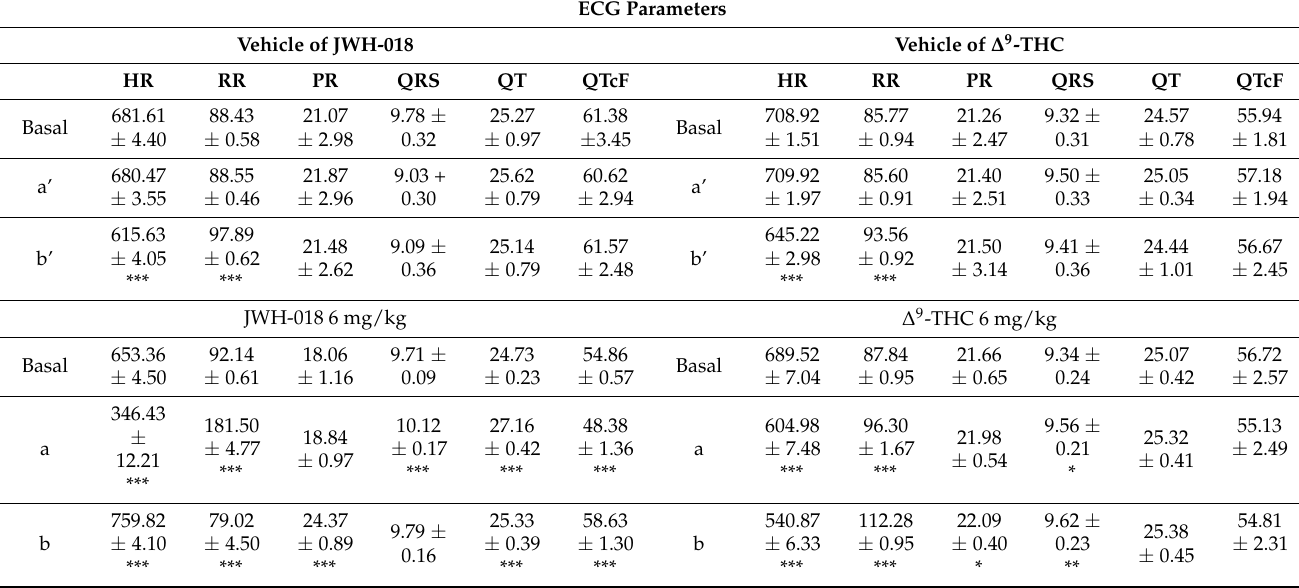
Table 1. Effect of systemic administration of vehicle (a’, b’), JWH-018 6 mg/kg (a and b) and ∆ 9 -THC 6 mg/kg on cardiac electrical parameters (ECG analysis). Data are relative to HR dose–response curve (Figure 2A,B). Data are expressed as mean overall effects of 15 evaluations for baseline and after vehicle or JWH-018 treatment of 4 mice. Data were analyzed with iox2 software, and they are expressed as MEAN ± SEM of evaluations recorded in 1-min time window, capturing data with an acquisition frequency of 1000 Hz. Statistical analysis was performed by Student’s t -test for each basal and after-treating parameter comparisons. * p < 0.05 ** p < 0.01 *** p < 0.001 vs. basal values. HR (bpm; Heart Rate), RR (ms; time between two consecutive peaks), PR (ms; time from the onset of the p wave to the start of the QRS complex), QRS (ms; is the time from the start to the end of the QRS complex), QT (ms; time from the beginning of the QRS complex to the end of the T wave), QTcF (QT/